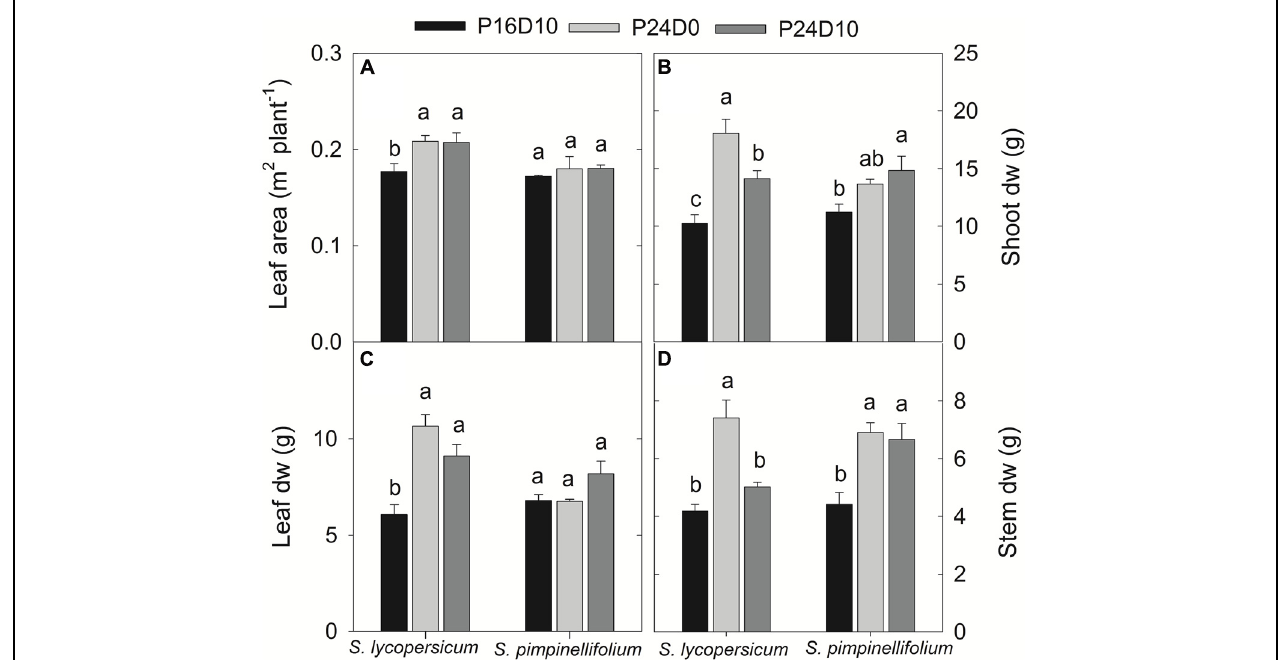
FIGURE 6 | Total leaf area (A), shoot dry weight (B), leaf dry weight (C), and stem dry weight (D) of plants grown in respective growth conditions. The harvests were done after 12 days of CL treatment. Vertical bars are SEM ( n = 4). Treatment means with different letters within each species are significantly different and the statistical analysis was done by the Tukey and Waller–Duncan k-ratio t